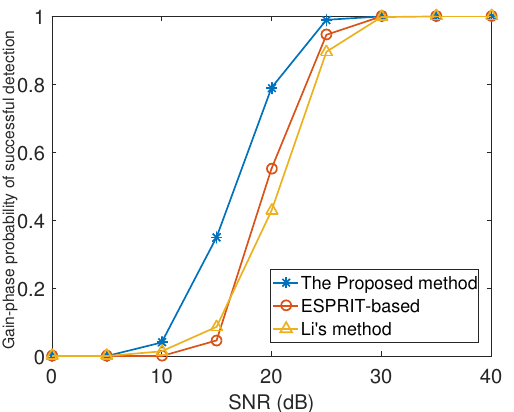
Figure 12. Probability of successful detection of gain-phase error estimation versus SNR, L =